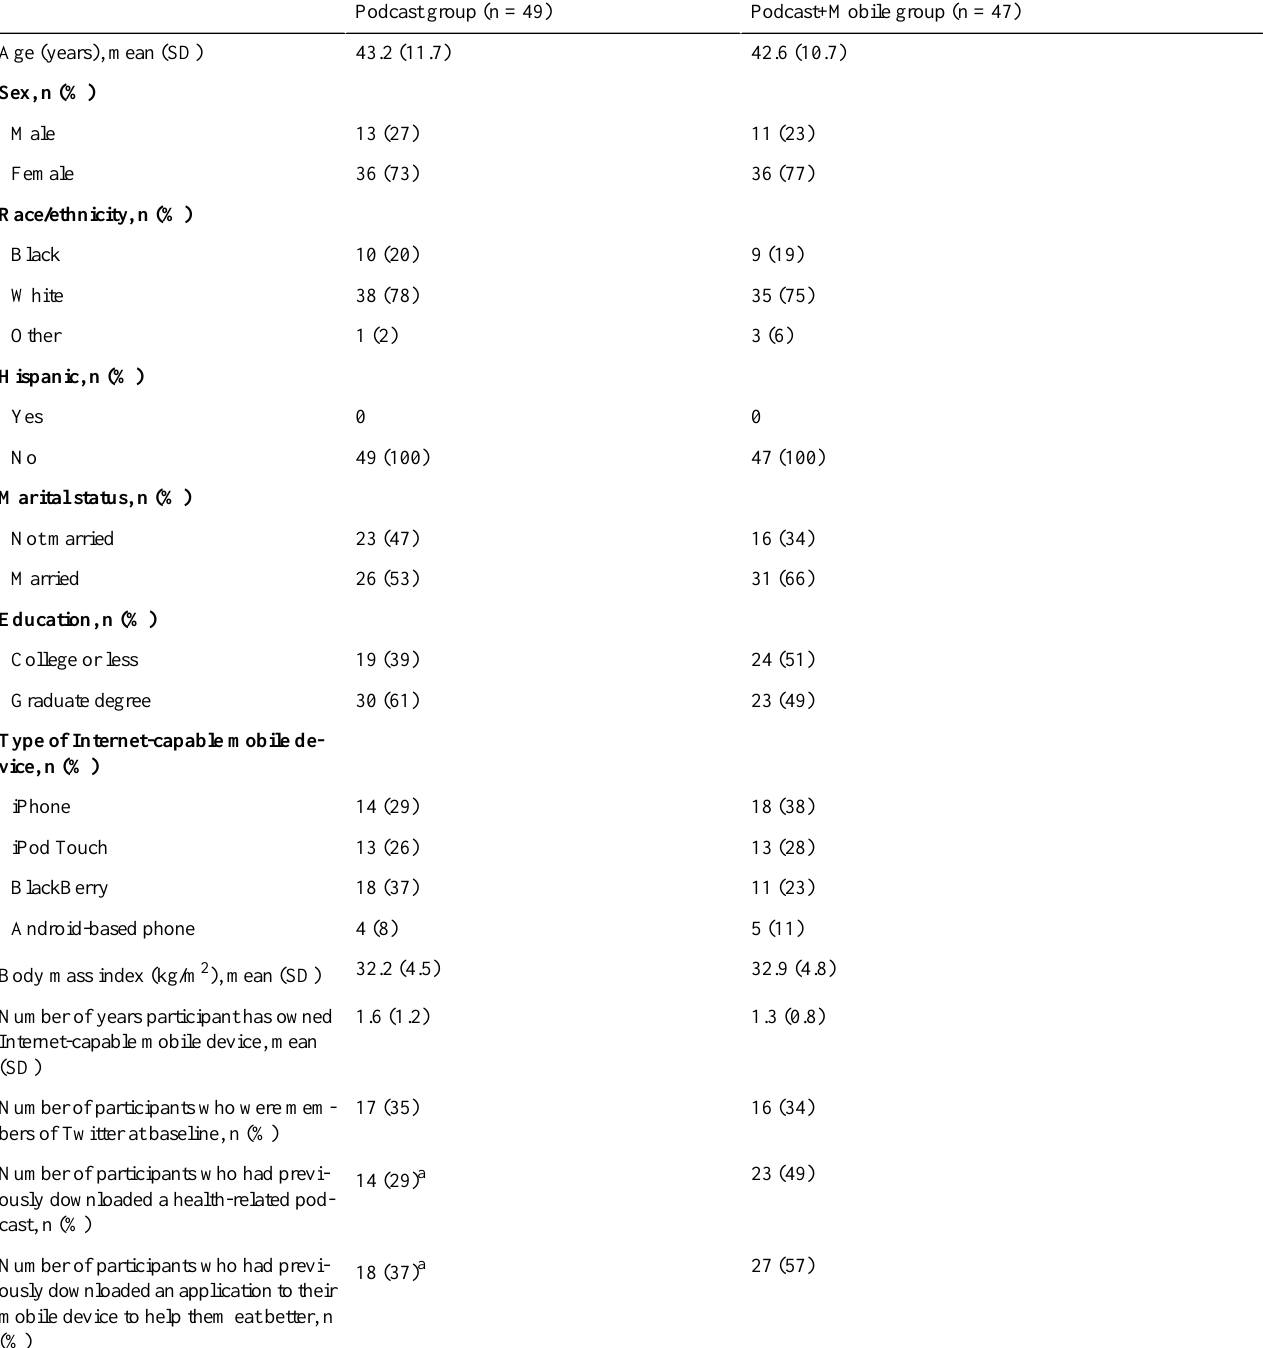
Table 1. Baseline demographic data for Podcast-only and enhanced Podcast+Mobile group participants